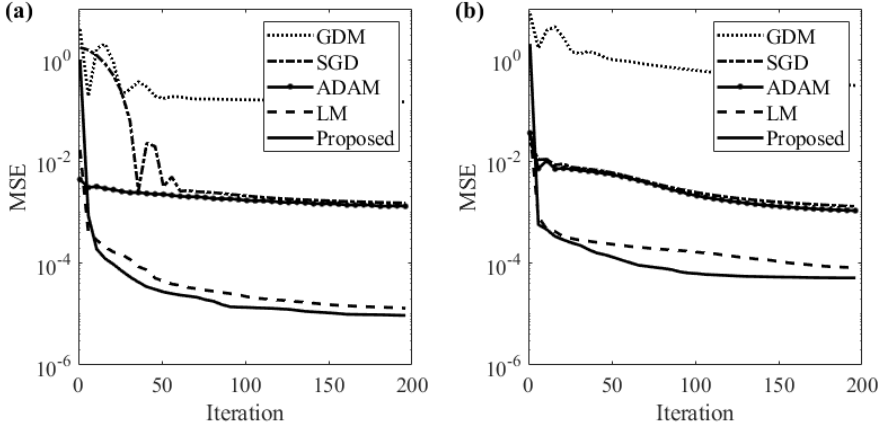
Figure 5. Training error convergences of the proposed training method and the previous methods: ( a ) Boston housing prices dataset and ( b ) automobile mileage per gallon dataset.